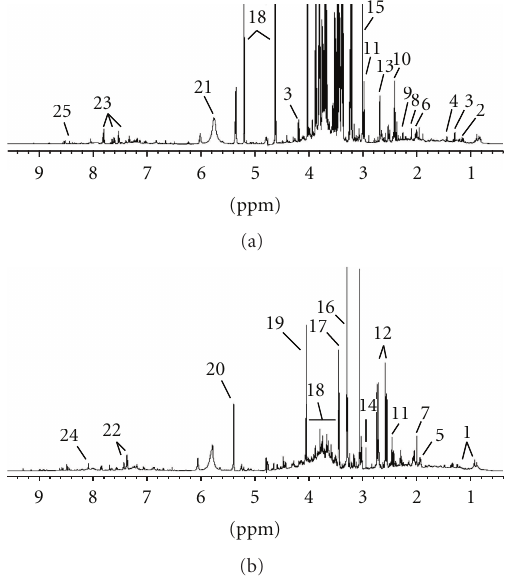
Figure 1: 1 H NMR spectra of urinary samples obtained from the GK rat (a) and Zucker obese rat (b), respectively. (1) leucine + isoleucine; (2) β -hydroxybutyrate; (3) lactate; (4) alanine; (5) acetate; (6) glutamate; (7) N-acetylglycoprotein; (8) methonine; (9) acetoacetate; (10) succinate; (11) 2-ketoglutarate; (12) citrate; (13) dimethylamine; (14) trimethylamine; (15) creatine + creatinine; (16) taurine; (17) taurine; (18) glucose; (19) creatinine; (20) allantoin; (21) urea; (22) phenylalanine; (23) hippurate; (24) N- methylnicotinamide; (25)